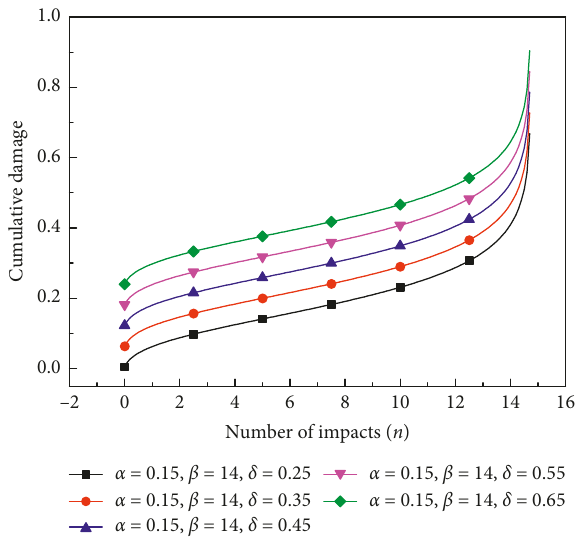
Figure 11: Influence of δ to the model curve.